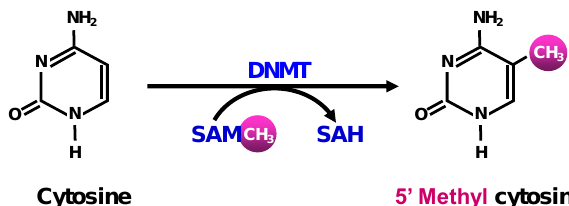
Figure 1. S-adenosyl methionine (SAM) donates a methyl group to cytosine to form 5′ methyl cytosine and S-adenosyl homocysteine (SAH).